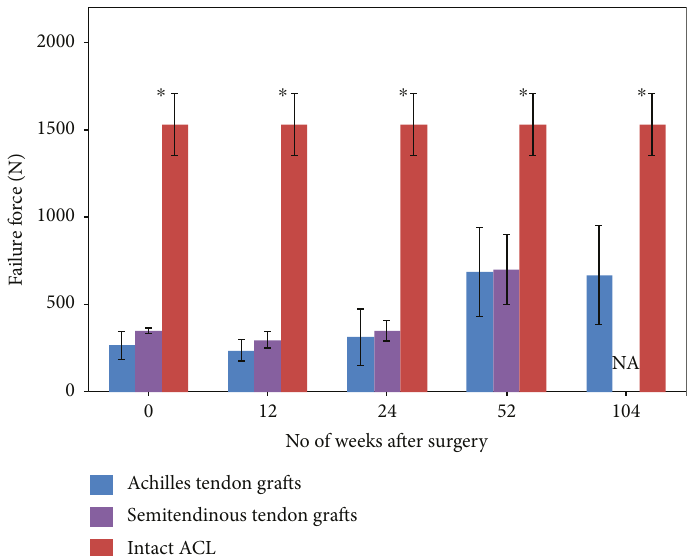
Figure 10: Comparison of failure force for autografts at various time points post ACL replacement surgery with intact ACL. ∗ Signi fi cant di ff erence ( p < 0 05 ) between autografts and intact ACL for the corresponding time period [61,